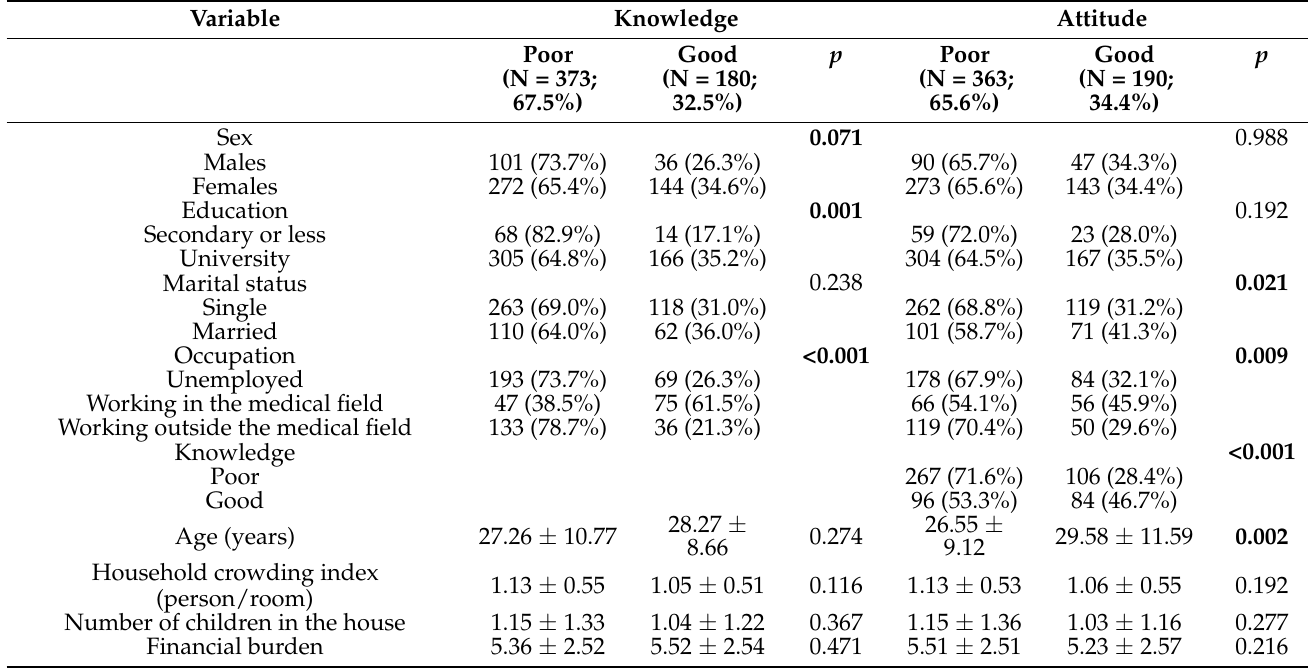
Table 5. Bivariate analysis of factors associated with good vs. poor cholera knowledge and attitude.